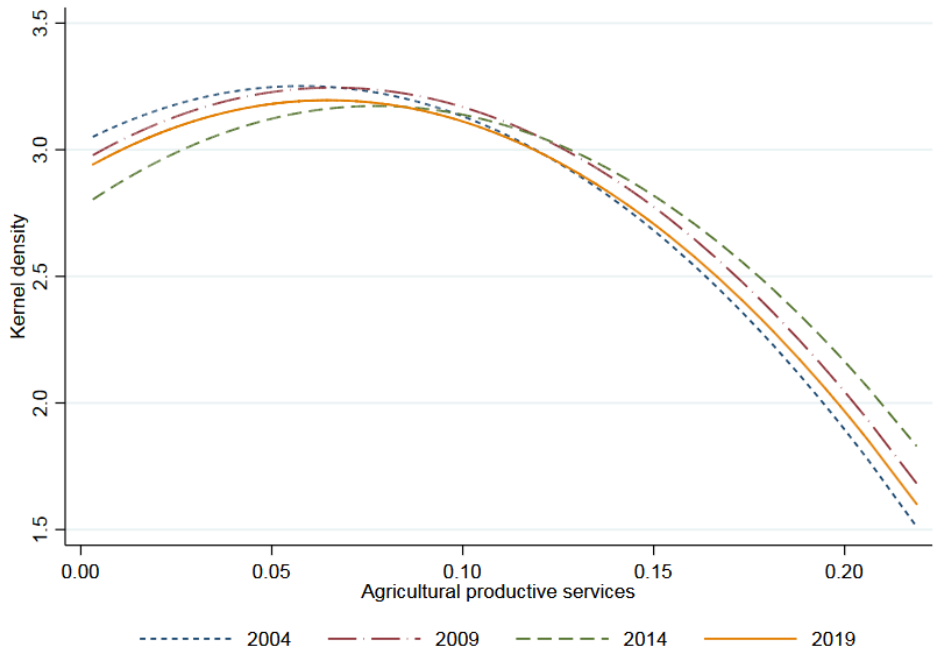
Figure 4. Kernel density of agricultural productive services.